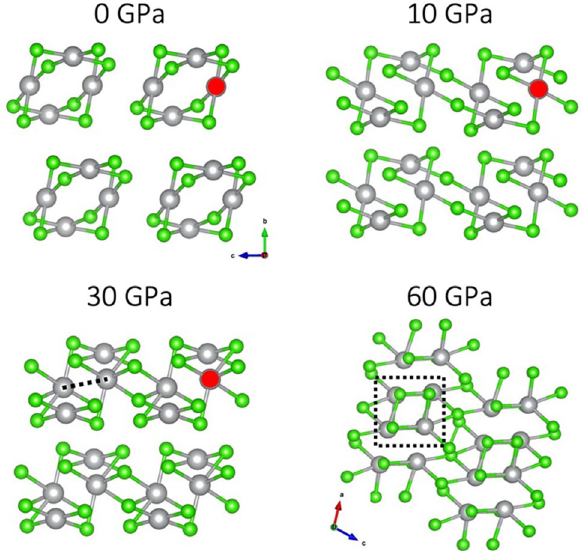
Figure 8. Structural transition of AuCl 2 -type polymorph in the SCAN picture. Nanotubes are viewed along the axis of propagation from 0 to 30 GPa. Note a different projection at 60 GPa, along the newly formed [AgCl] square nanowires. Red circles mark the Ag atom which experiences the pronounced changes in local coordination in the 0–30 GPa range.